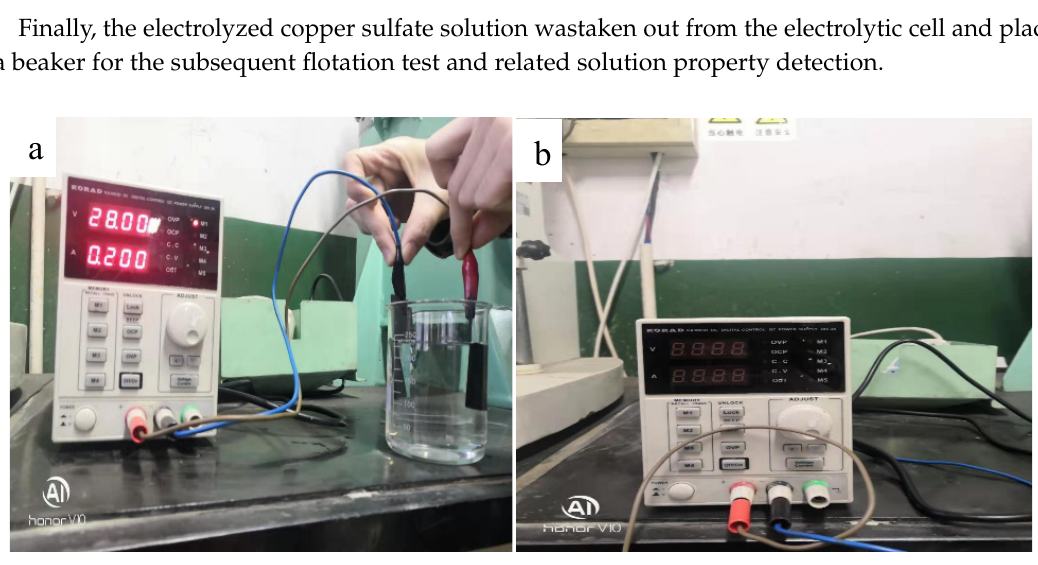
Table 2. Electrochemical pretreatment conditions.